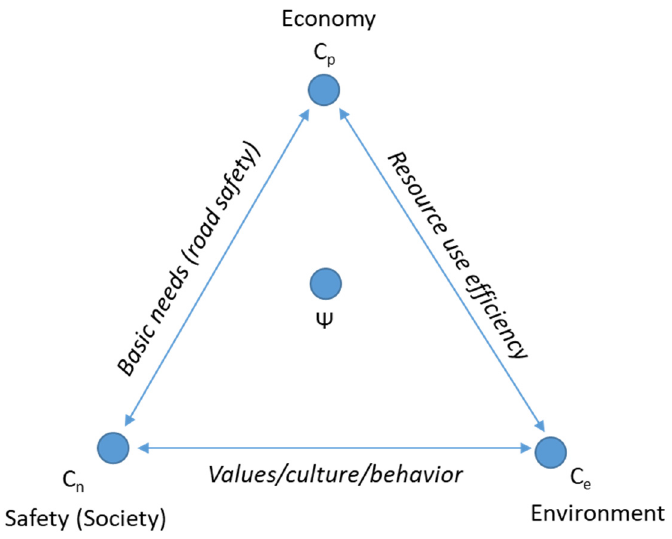
Figure 1. Sustainable development of a road tunnel: balance of safety, economy, and environment.